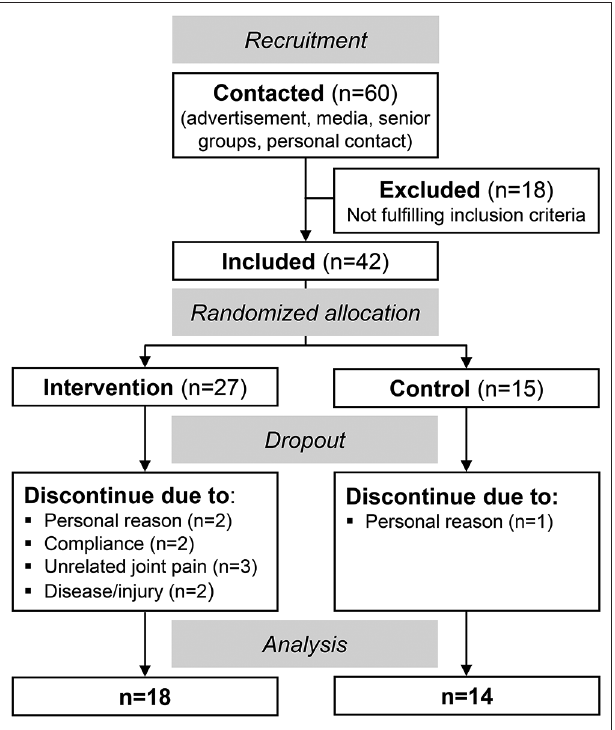
FIGURE 1 | Flow chart illustrating the progress of the intervention